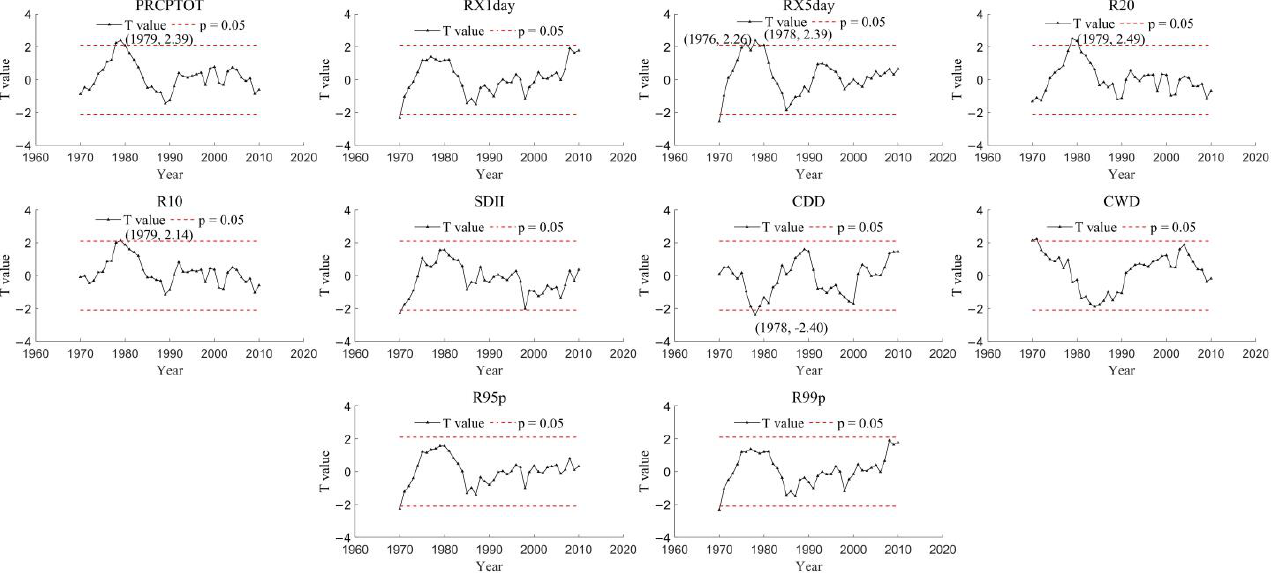
Figure 7. Moving T-test for each EPI within Hubei province in spring during 1960 – 2019.